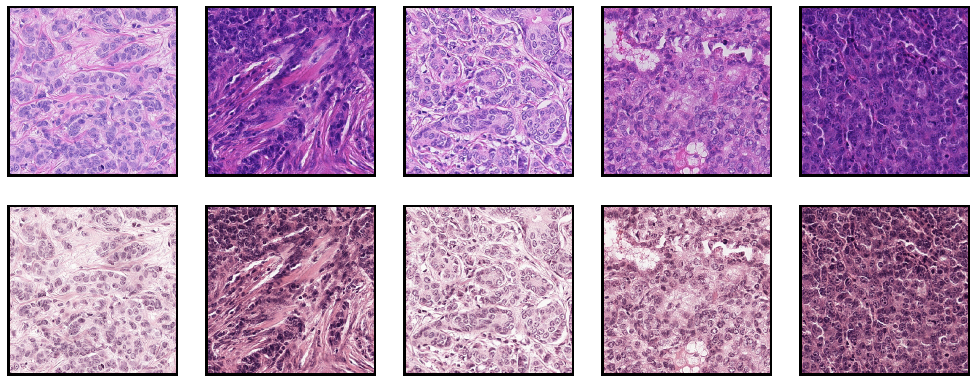
Figure 11. Exemplary tiles from the UMCU dataset ( top row ) and the transformed tiles after applying the stain normalization for the RUMC dataset ( bottom row ) using StainCUT.